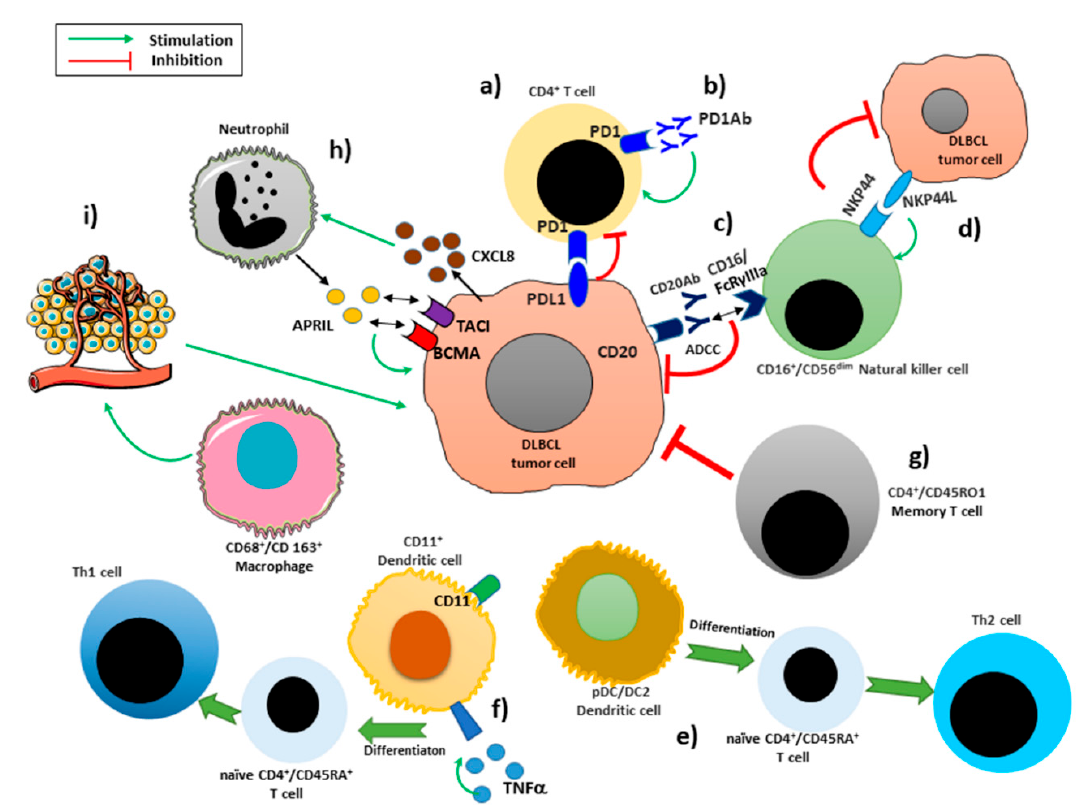
Figure 1. Some interactions involving the immune infiltrating cells in DLBCL microenvironment. The activation of PD-1 by its ligand PD-L1 induces the block of cell-cycle progression in CD4+ T cells ( a ). Antibodies blocking the interaction PD-1/PD-L1 restores the T cell mediated antitumor immune response ( b ). NK cells recognize CD20-Ab-coated cells by the type IIIA Fc receptor (FcR γ IIIa; CD16a) and trigger NK cell-mediated ADCC, resulting in rapid NK-cell activation and degranulation ( c ). The activation of NKp44 improves the role of NK-cells against malignant cells ( d ). pDC/DC2 dendritic cells stimulate antigen naïve CD4+CD45RA+ T cells to differentiate into Th2 ( e ). DC1s are stimulated with tumor necrosis factor α (TNF α ) acquire the capacity to induce the differentiation of naïve CD4+CD45RA+ T-cell to Th1 cells ( f ). Memory T characterized by a CD4+/CD45RO1 phenotype decrease the tumor proliferation rate ( g ). Tumor cells are able to recruit neutrophils considered as the major source of APRIL, through the release of CXCL8. APRIL binds to BCMA and TACI stimulating B cell maturation and differentiation and survival ( h ). CD163+ macrophages enhance immunosuppression and angiogenesis in tumor progression ( i ).